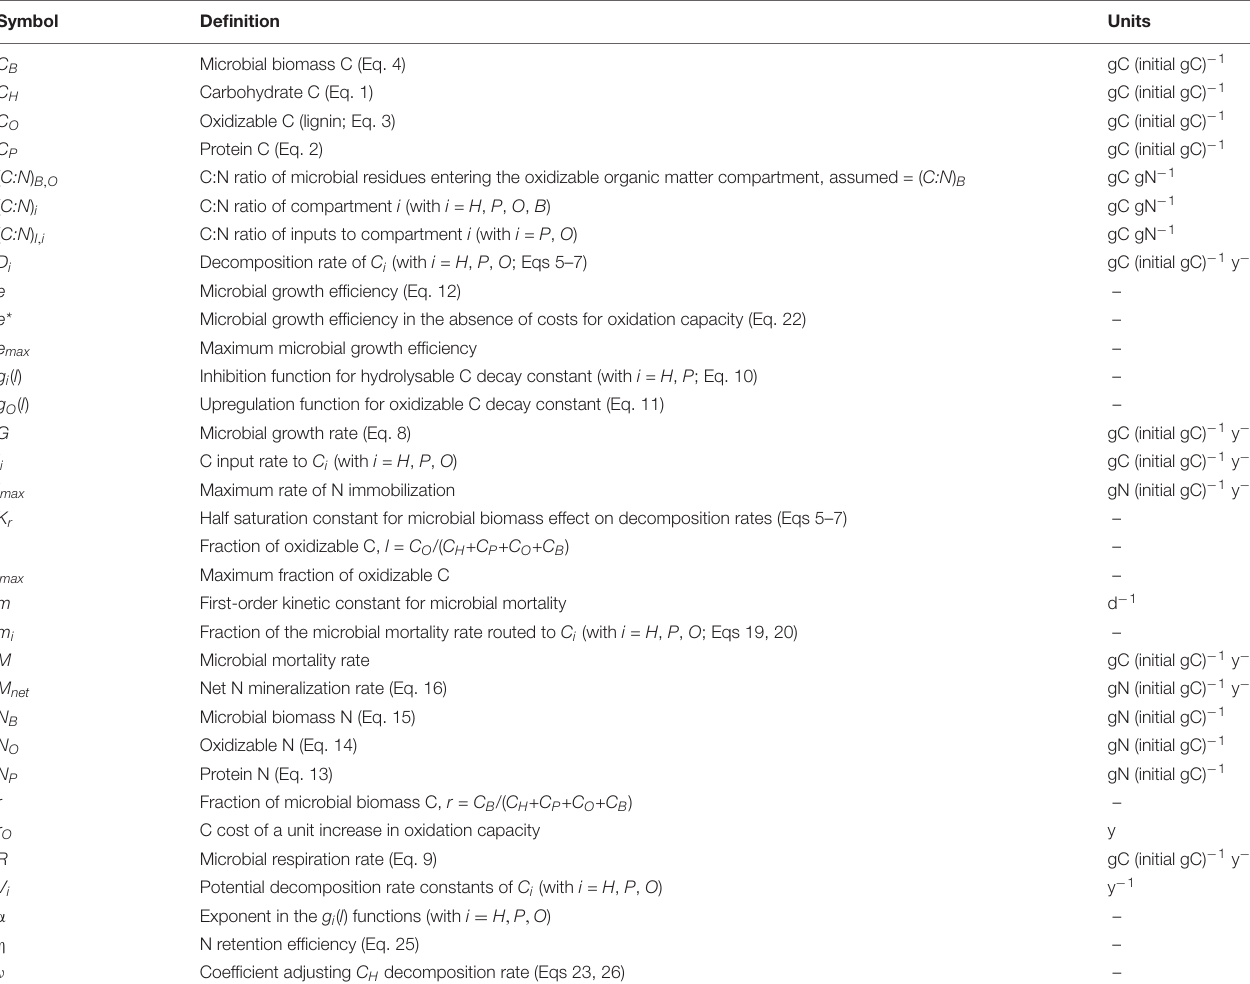
TABLE 1 | Symbol definitions and